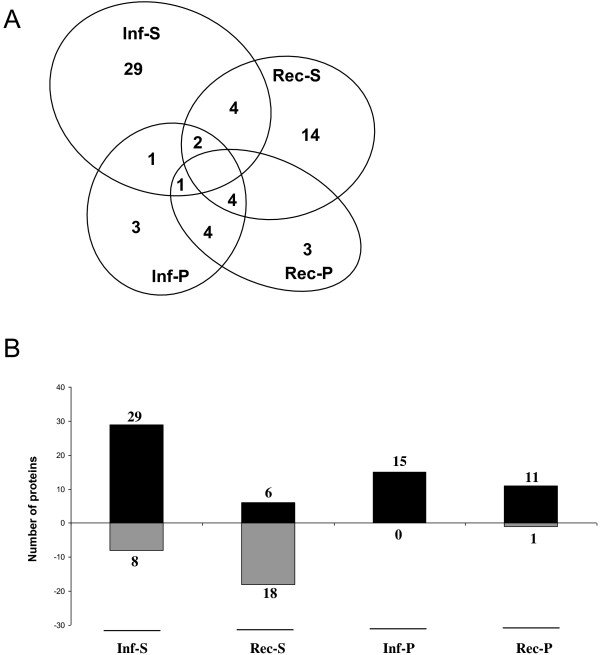
Protein distribution and expression trend in infected and recovered plants. A) Venn diagram showing the distribution of the differentially expressed proteins in each category. B) Induced and repressed grapevine proteins in response to infection and in recovered plants. Inf: infected. Rec: recovered. S: Sypro® Ruby staining (total proteins). P: ProQ Diamond staining (phosphorylated proteins).